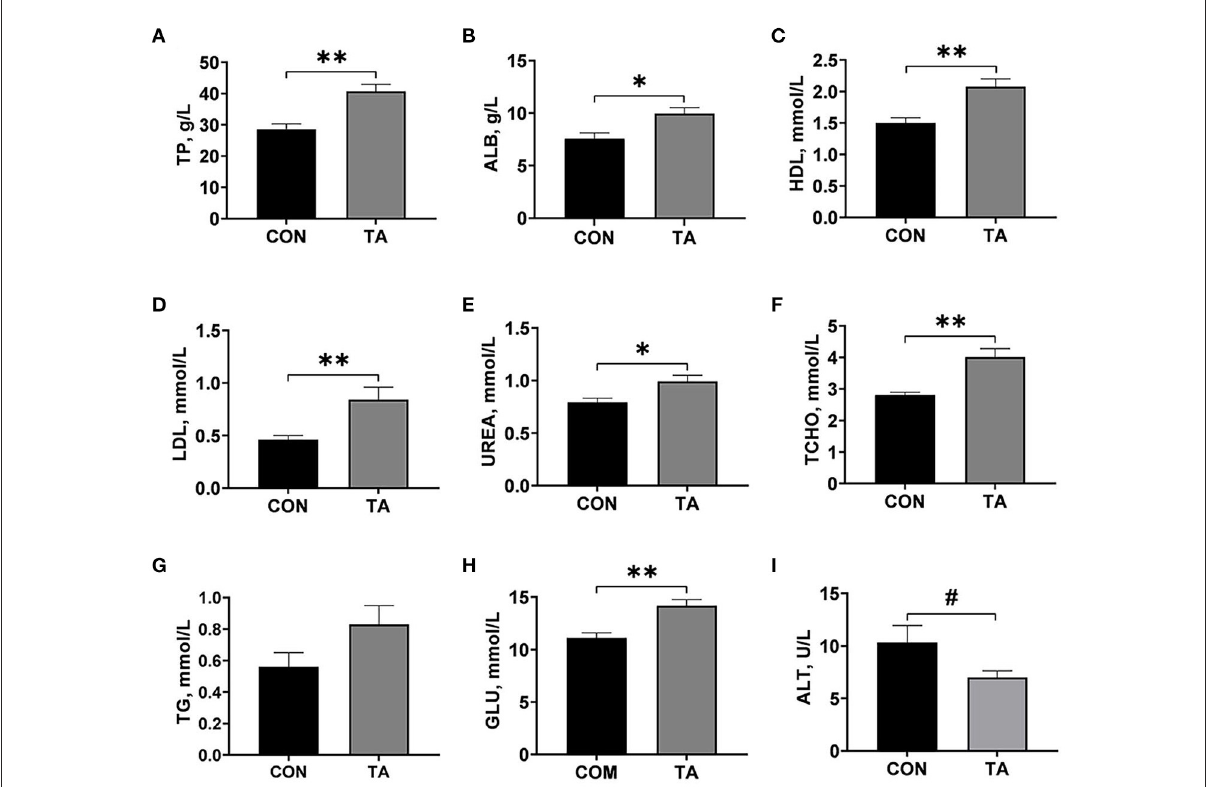
FIGURE1 Effects of dietary supplemented with microencapsulated TA from Galla Chinensis on serum biochemical parameters of broiler chickens. (A) Total protein (TP), (B) Albumin (ALB), (C) High density lipoprotein (HDL), (D) Low density lipoprotein (LDL), (E) UREA, (F) Total cholesterol (TCHO), (G) Triglycerides (TG), (H) Glucose (GLU), (I) Alanine transaminase (ALT). CON, broiler chickens fed a basal diet; TA, broiler chickens fed a basal diet supplemented with 300 mg/kg microencapsulated TA from Galla Chinensis . Values are mean ± standard error ( n = 6). * P < 0.05, ** P < 0.01, # 0.05 < P <